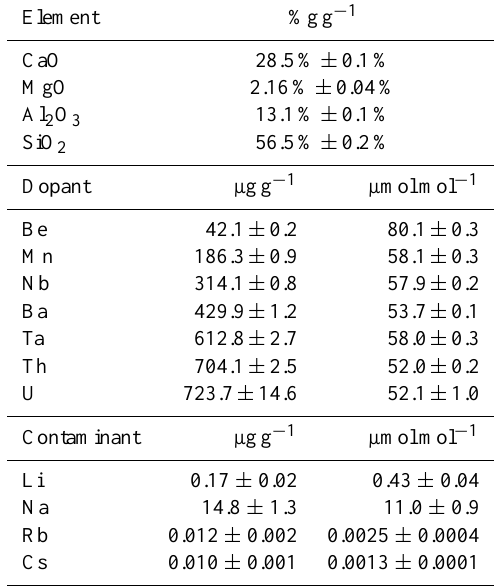
Table 2. Major and trace elemental composition of glass Tune-1. Errors are 1 σ . Major elements from EPMA, minor elements from ICPMS.